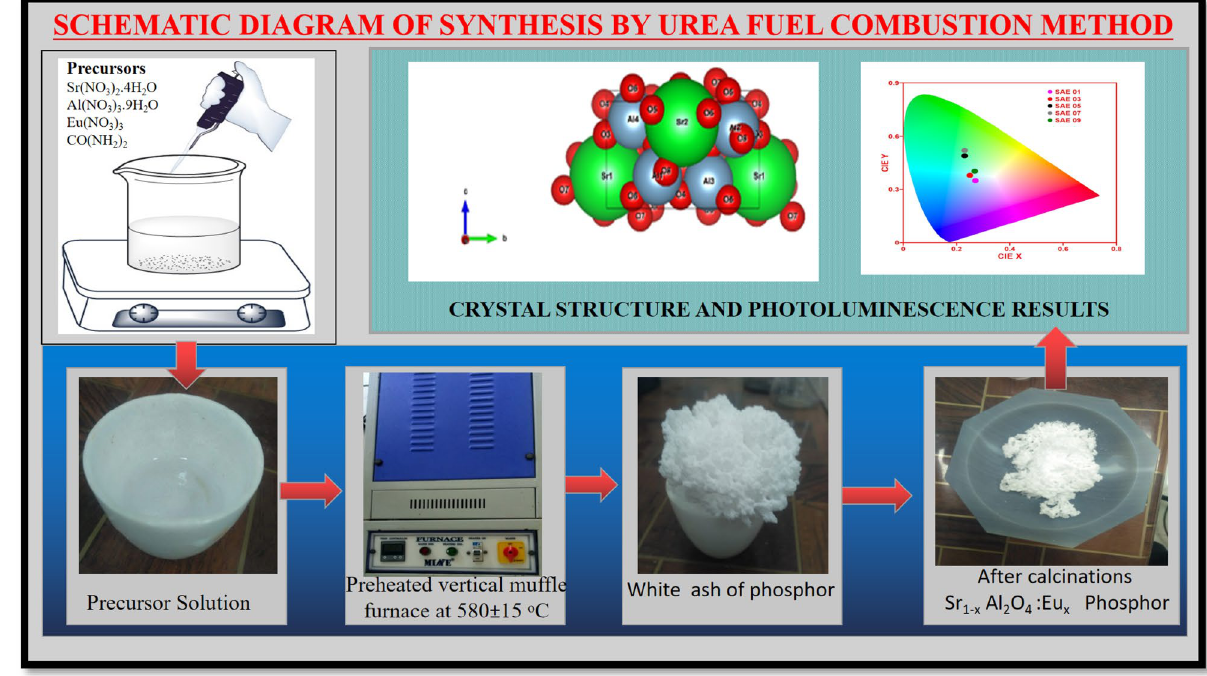
Figure 1. Schematic diagram for urea fuel Combustion synthesis